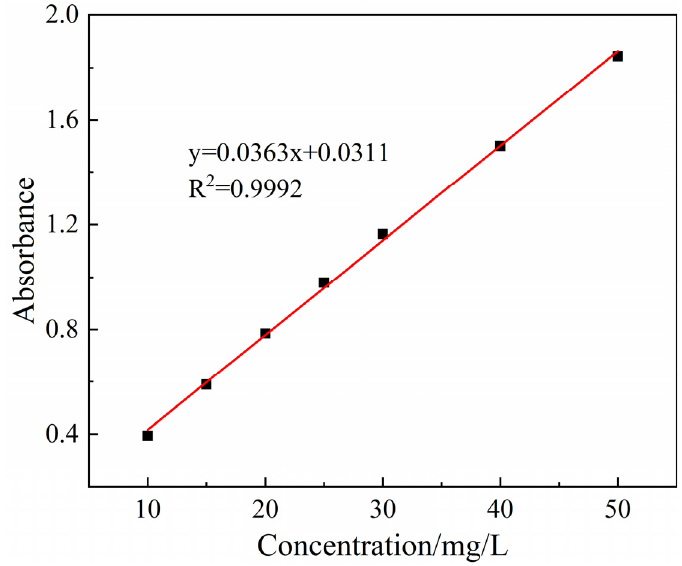
Figure 1. Standard curve of pyridine.